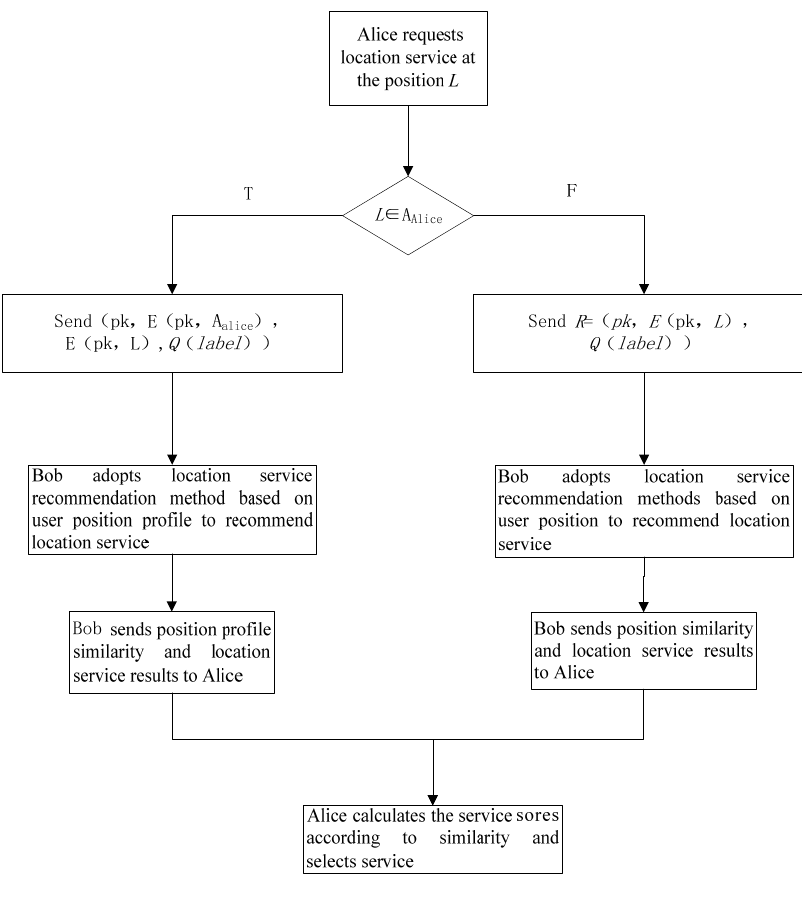
Figure 3. LBS service flow chart.